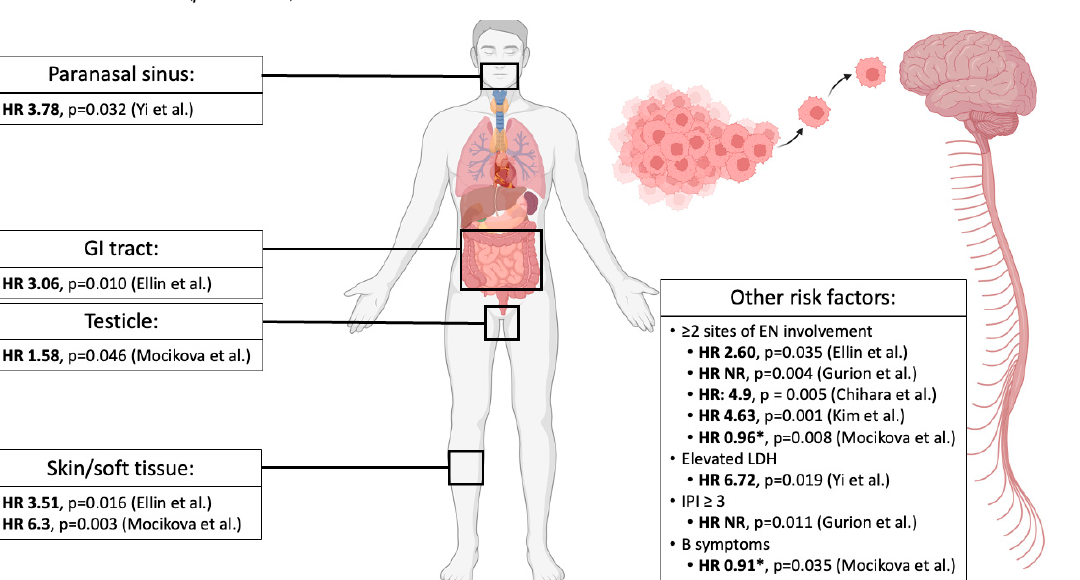
Index. * Hazard ratio values were reported as significant risk factors for CNS progression/relapse by the authors though directionality of ratio was not reported